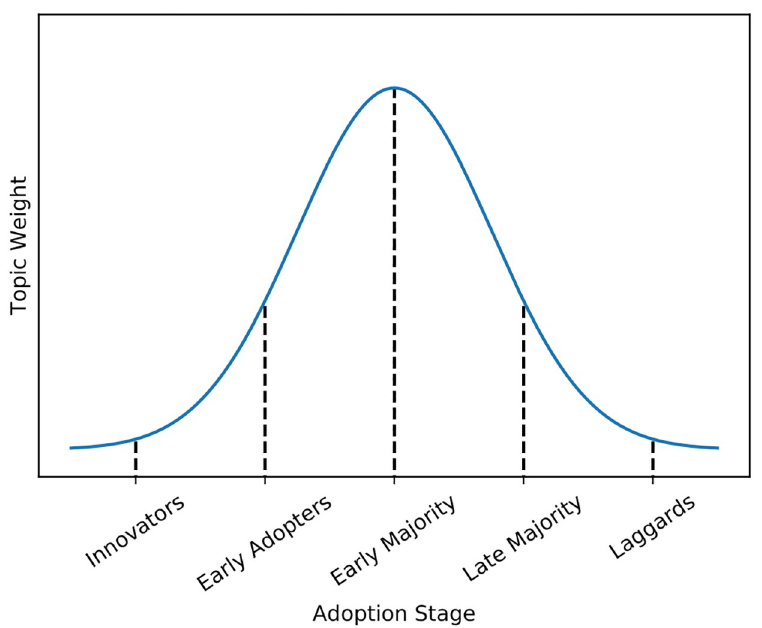
Fig 2. The diffusion of innovations. Adopters were categorized as innovators, early adopters, early majority, late majority and laggards depending on their adoption time.